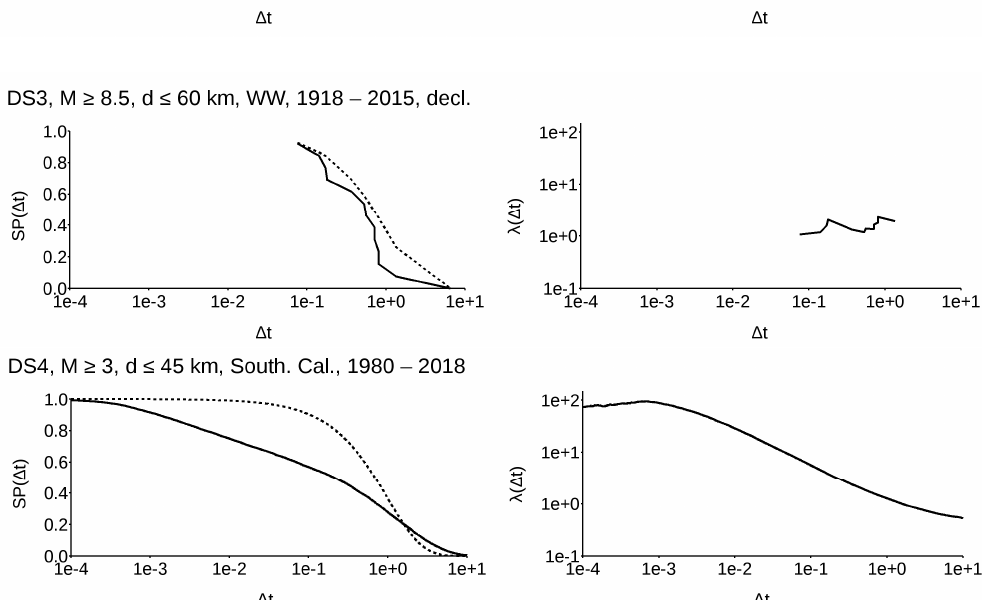
Figure 1. Survival probability ( left ) and λ ( ∆ t ) ( right ) for datasets 1–4 (DS1–DS4). Solid lines refer to empirical functions, while dashed lines refer to Poissonian ones.